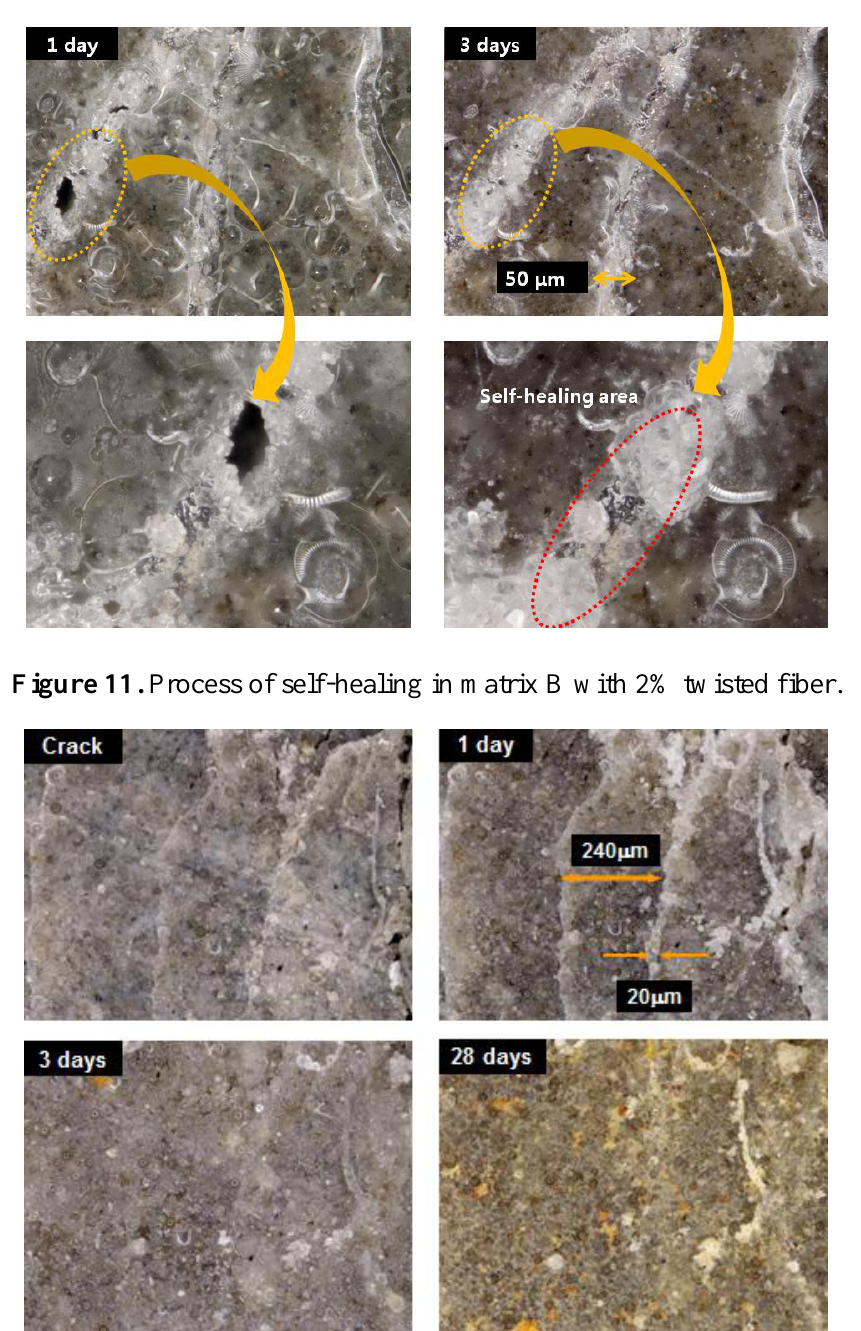
Figure 10. Process of self-healing in matrix A with 2% twisted fiber.